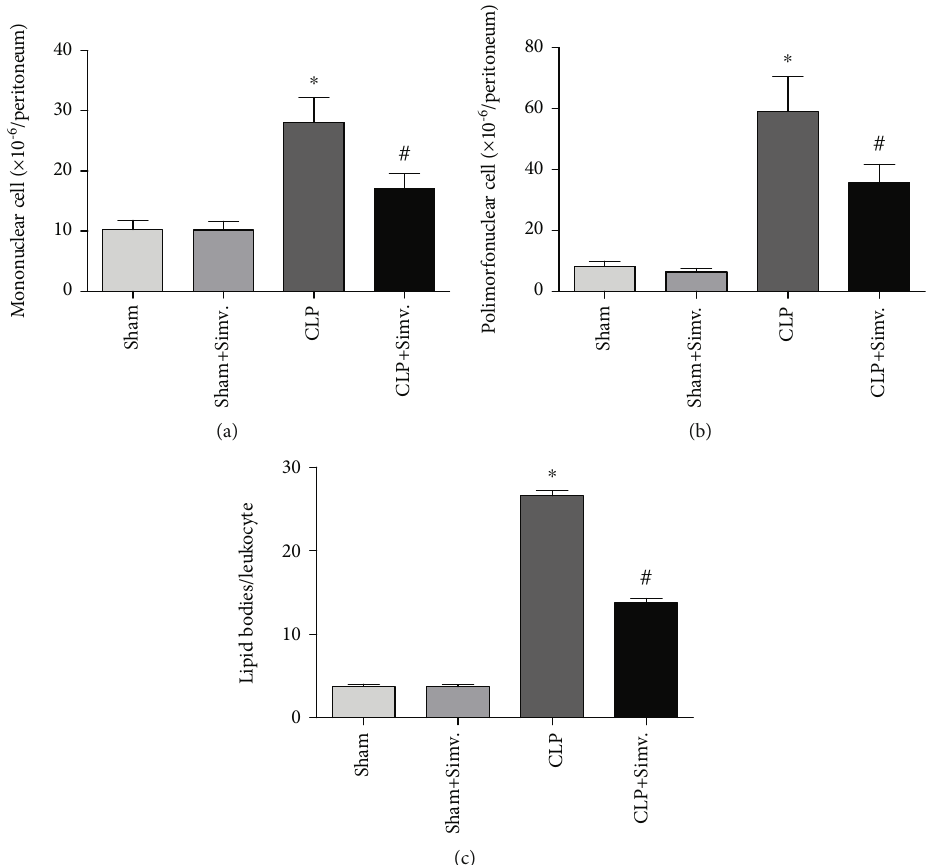
Figure 4: Representative images of lipid bodies staining. The images were captured at 1000x in a light microscope denoting black dots in the cells called lipid